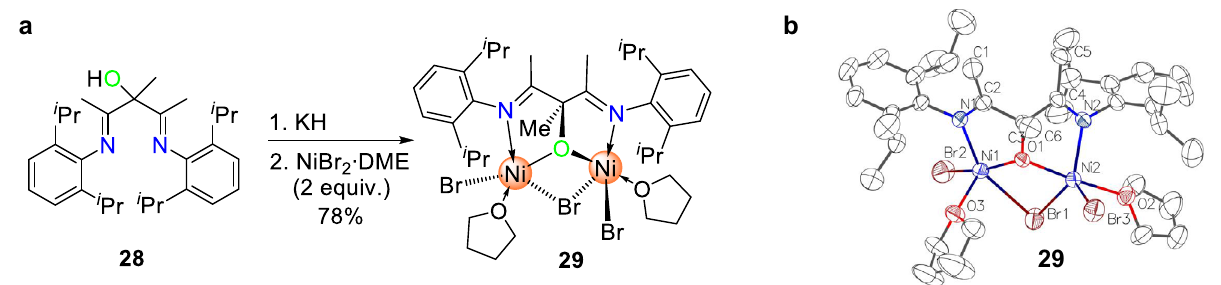
Fig. 4 Synthesis and structure of 29. a Synthesis of complex 29 . b Single crystal structure of complex 29 .